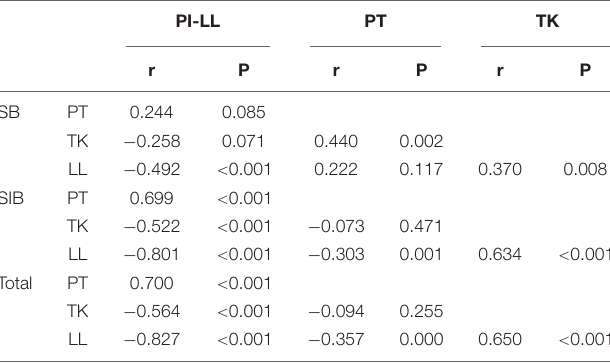
TABLE 3 | Correlation analysis among PI-LL, PT, and TK in matched and unmatched groups.